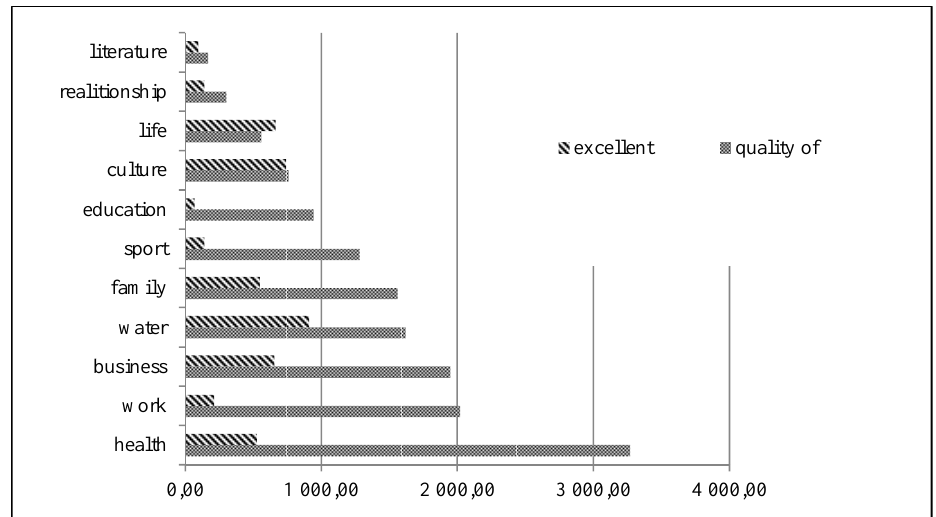
Diagram 3 – Millions of matches on Google on May